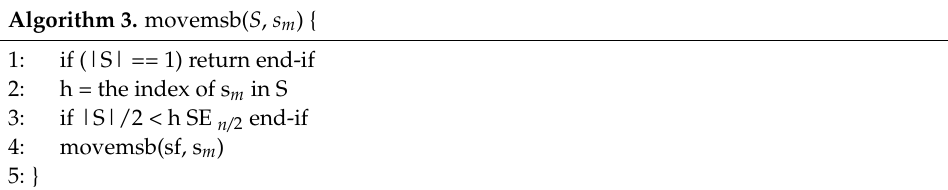
Algorithm 3. movemsb( S , s m )